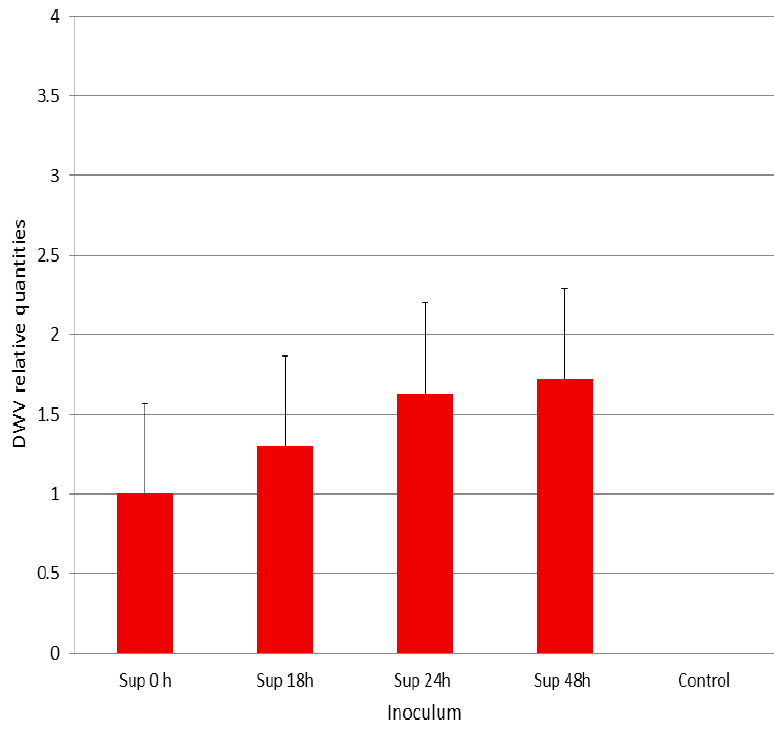
Figure 4. Infectivity of DWV-P1 to P1 cells. Y -axis, relative amount of DWV genomic copies, normalized expression in respect to the virus bound to the cells for 0.5 h of incubation and wash (Sup. 0). X -axis, supernatant from P1 DWV-infected cells (DWV-P1) collected at various hours (h) p.i. used as inoculum. Control, supernatant from mock-infected cells used as inoculum. Bars represent standard error values. One-way ANOVA (F = 0.6954, P = 0.6333).